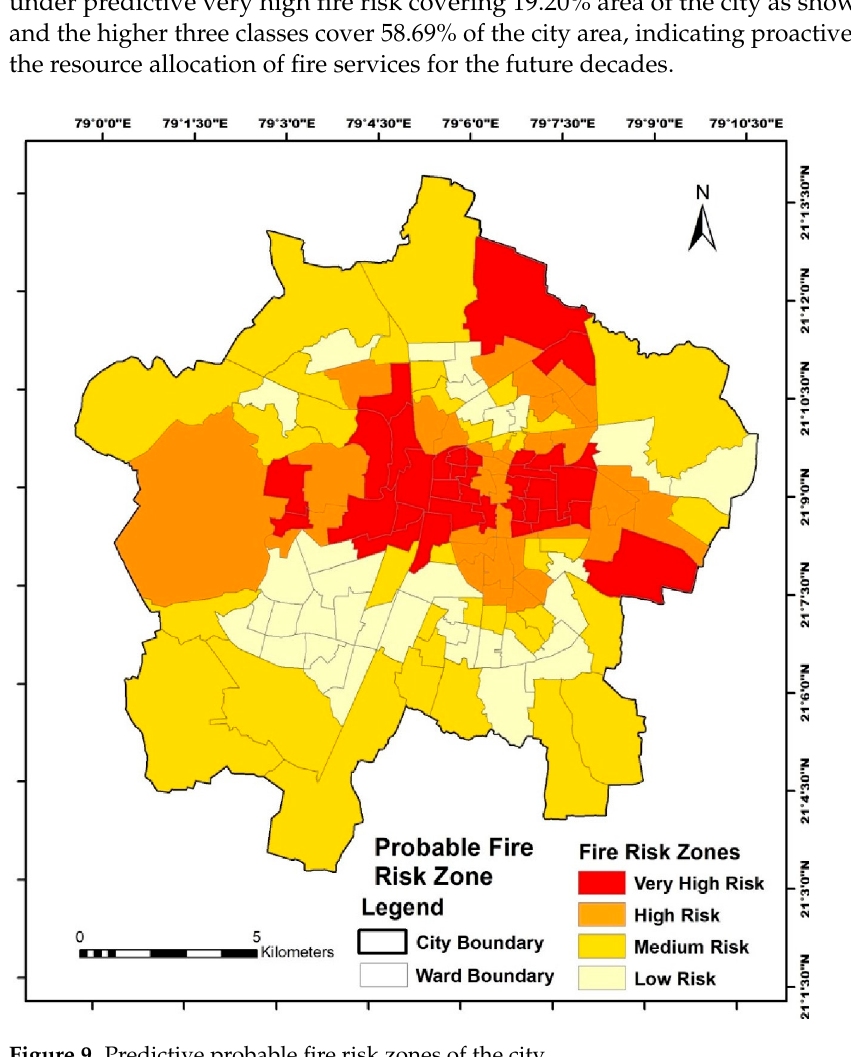
Figure 9. Predictive probable fire risk zones of the city .